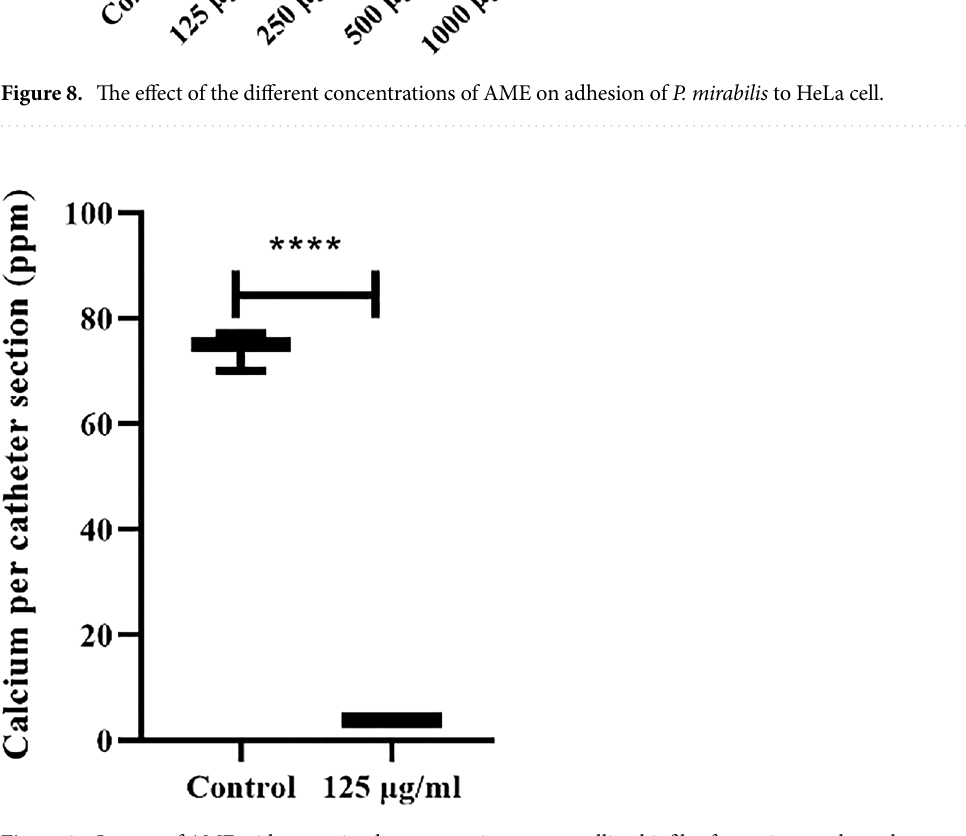
Figure 9. Impact of AME with an optimal concentration on crystalline biofilm formation on the catheter. *** P <